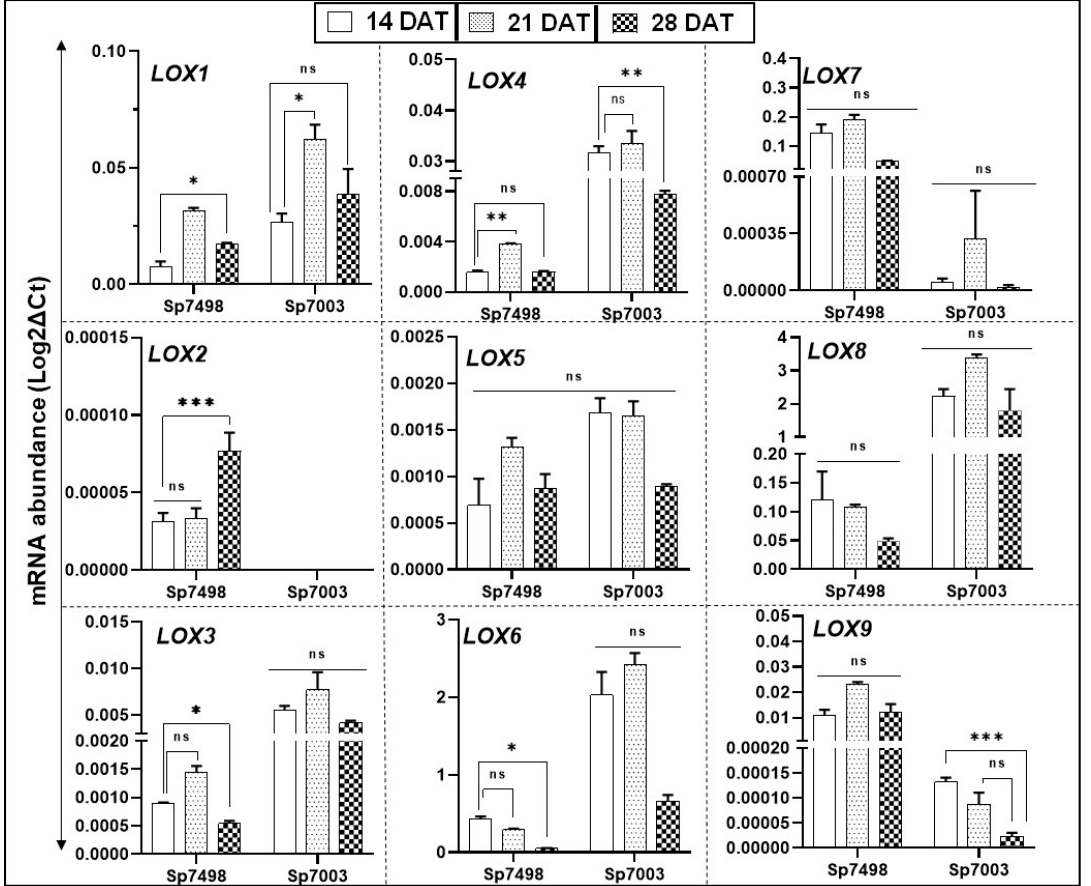
Figure 5. qRT-PCR analysis of LOX genes in two clones of Spirodela polyrhiza , Sp7498and Sp7003. Cultures were grown for 28 days in nutrient solution and samples collected at 14, 21, and 28 days of growth. Confluence of plants in the culture flasks was reached after 21 days of growth. mRNA expression profiles of whole plants from the two clones were analyzed. SpACT and Sp18SrRNA housekeeping genes were used to normalize the expression of LOX genes, as described in Materials and Methods. Analysis of variance (ANOVA) with Dunnett’s multiple comparisons test was performed for significant differences in LOX gene expression in the aging plants. Statistical significance between expression data points was assessed against the 14-day expression profiles and categorized as * p < 0.05, ** p < 0.01, and *** p < 0.001 using Graph Pad (version 8.0); ns: not significant.